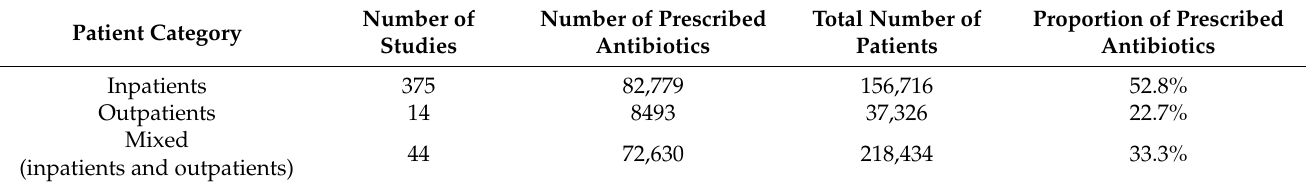
Table 1. Healthcare settings and antibiotic prescribing in COVID-19 patients from studies